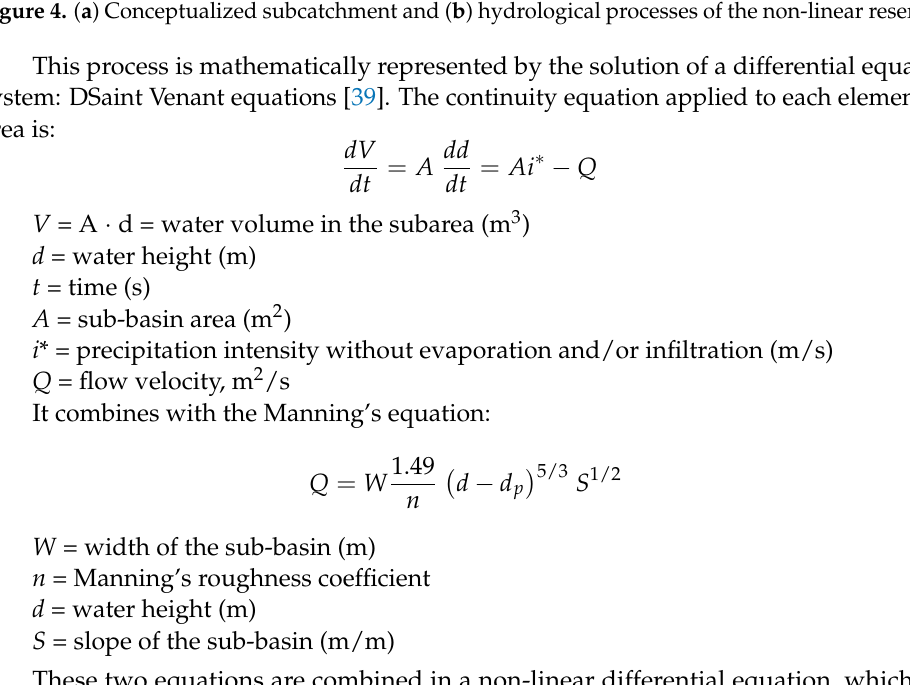
Figure 4. ( a ) Conceptualized subcatchment and ( b ) hydrological processes of the non-linear reser- voir .